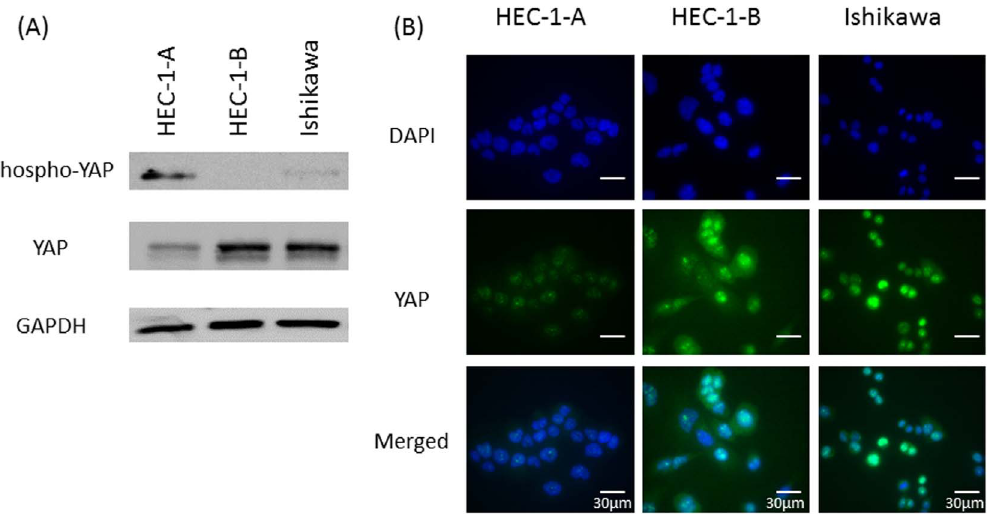
Figure 2. (A) Expression of YAP and phospho-YAP (Ser127) in three EMCA cell lines by western blotting. (B) Immunofluorescent cytochemical staining of endogenous YAP using anti-YAP antibody (YAP: green, DAPI: blue).